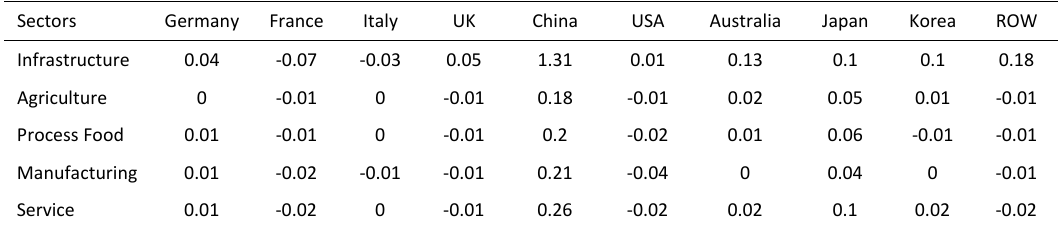
Table 6: Change in aggregate imports by sector (%)